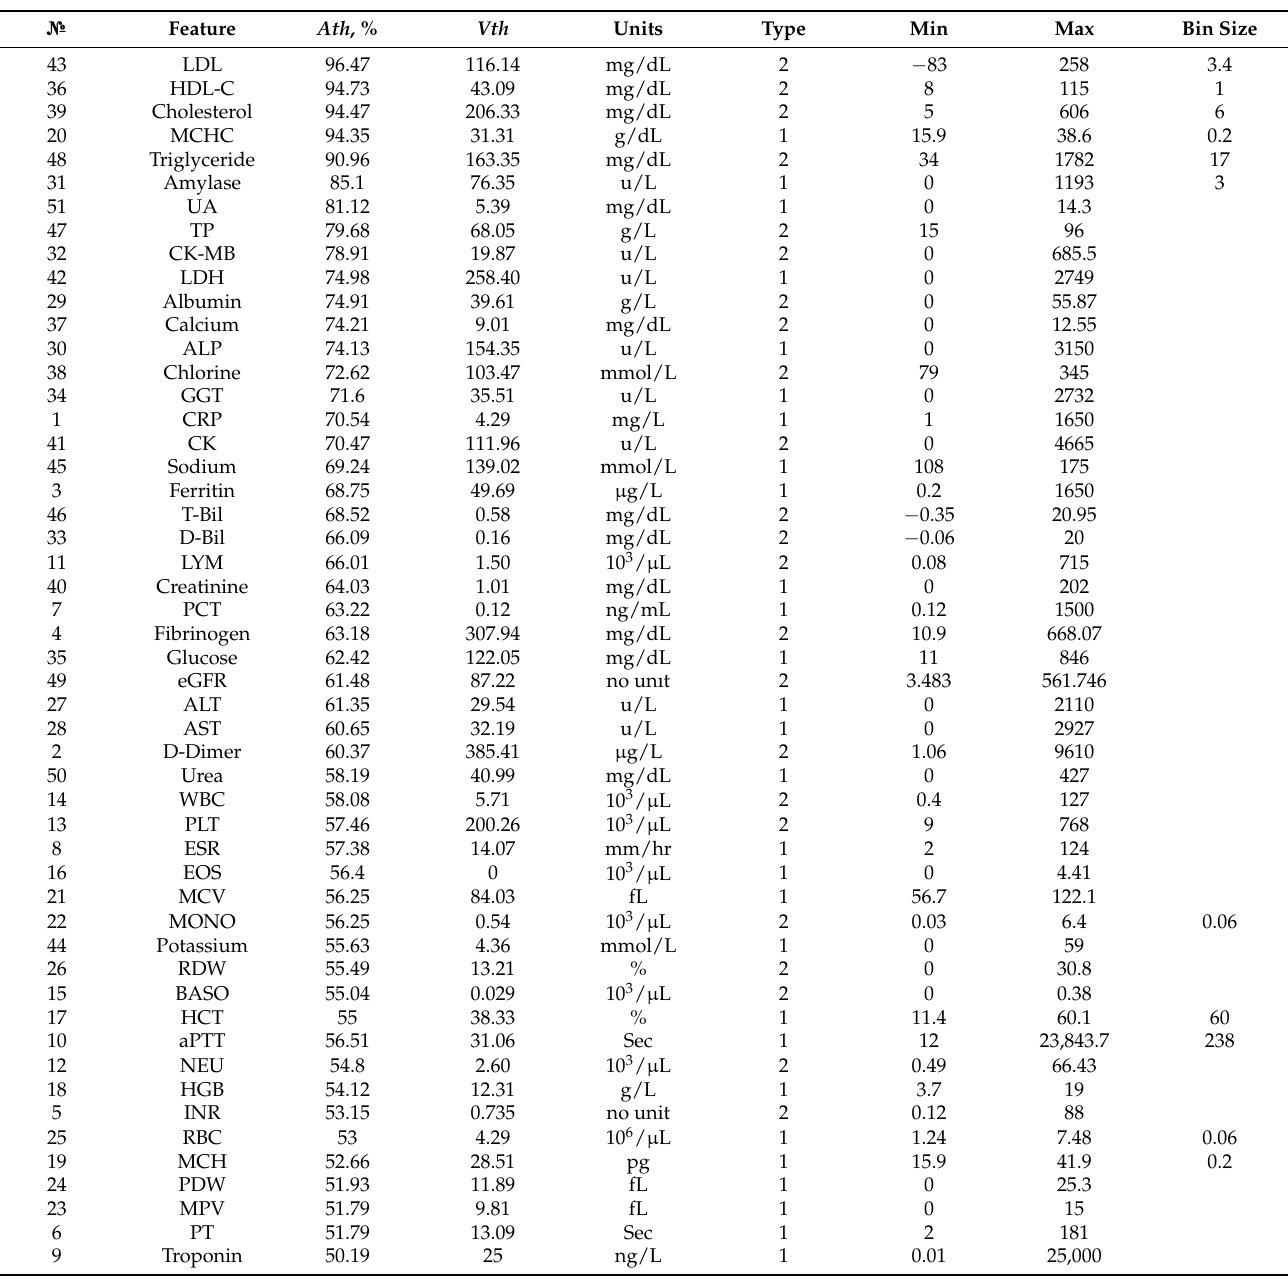
Table A1. Threshold method parameters for SARS-CoV-2-RBV1 dataset and histogram bin sizes for Figures 6 and